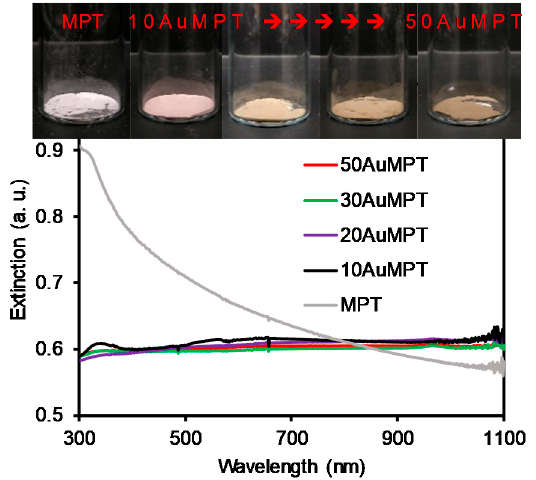
Figure 3. Digital photos and absorption patterns of bare MPT (mesoporous TiO 2 ) and various AuNP-loaded MPT composite particles.